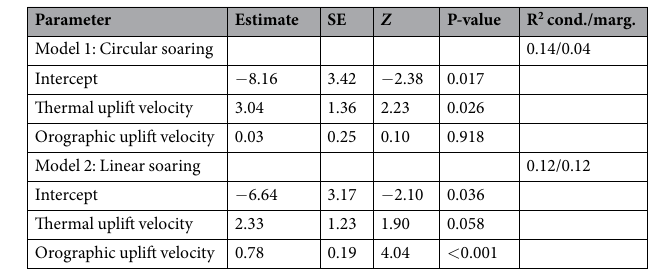
Table 1. Summary of binomial GLMMs testing the effect of orographic and the thermal uplift velocities (m/s) on soaring modes. The response variable was 1 if the track segment was classified as linear soaring or circular soaring (depending on the model) and 0 if classified as gliding. Model fixed factors were orographic and thermal uplift velocities, and random factors were bird identifier and the day of data collection. Conditional and marginal R 2 were calculated following Nakagawa and Schielzeth 66